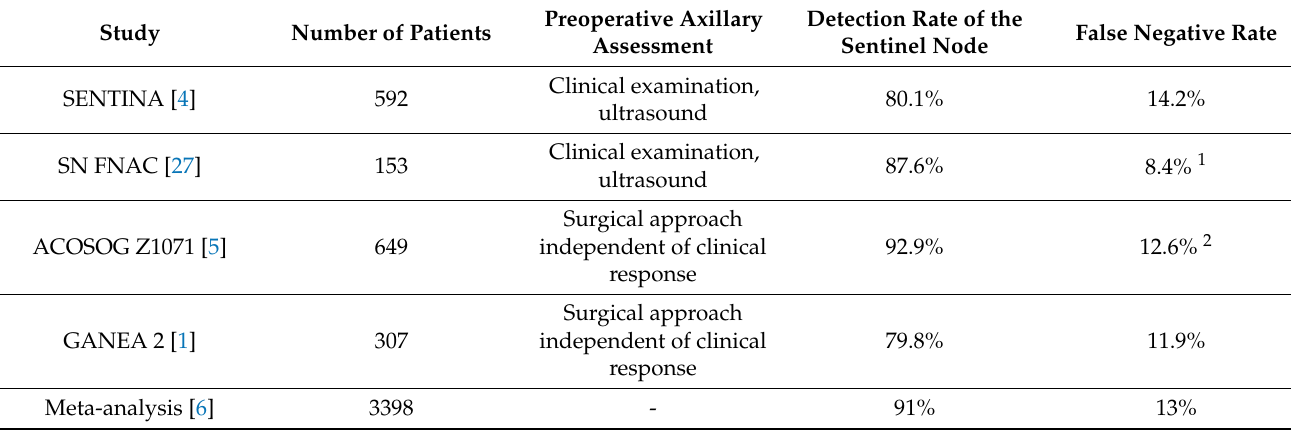
Table 3. Studies on sentinel node biopsy after neoadjuvant therapy in initially node-positive